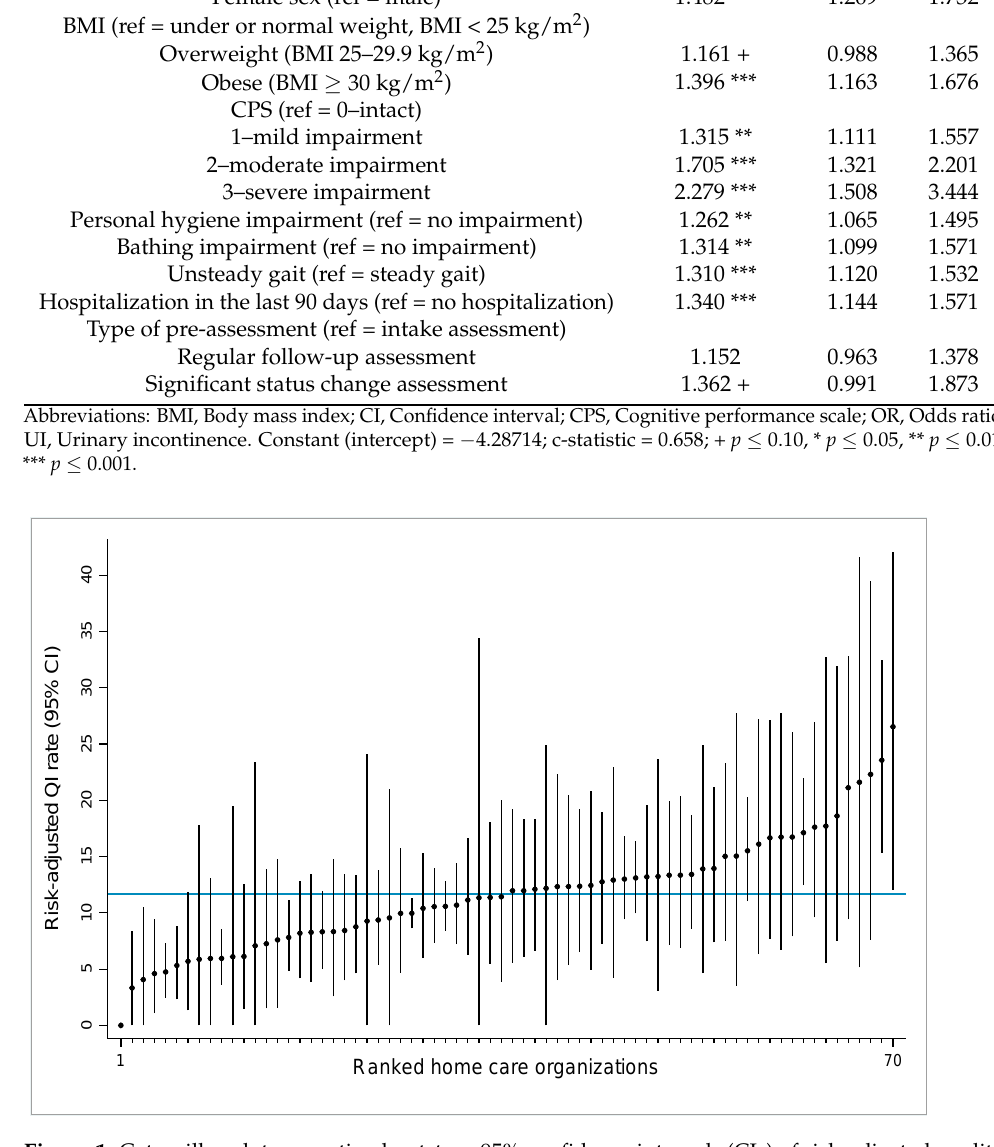
Figure 1. Caterpillar plot presenting bootstrap 95% confidence intervals (CIs) of risk-adjusted quality indicator (QI) rates of worsening or onset of urinary incontinence for 70 home care organizations. CIs are based on 10,000 bootstrap resamples. Organizations are ordered from 1 – 70 on the x -axis by the risk-adjusted QI rate (rank 1 corresponds to the organization with the lowest QI rate). The blue solid horizontal line shows the total QI rate (client population mean).